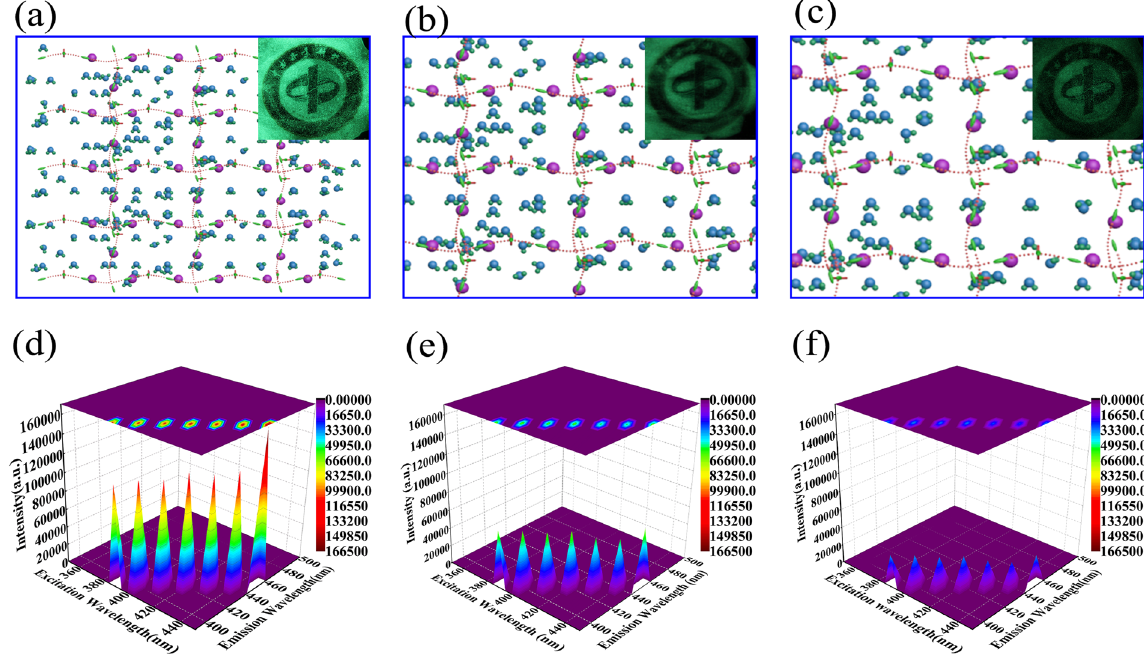
Figure 5. The structural model of hydrogel, inset shows the typical optical micrograph image of hydrogel of different swelling ratios respectively for 50 times( a ), 100 times( b ), 150 times( c ). Excitation − emission maps of hydrogel absorbed the water ( d ) 50 times, ( e ) 100 times, ( f ) 150times and the corresponding contour